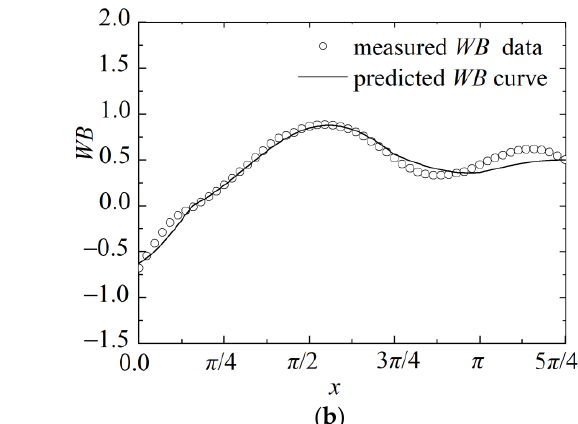
Figure 10. Comparisons of measured curve and predicted curve: ( a ) comparison of predicted 𝑞 √ℎ⁄ − 𝑛 √ℎ⁄ curve and measured data; ( b ) comparison of predicted 𝑚 ℎ⁄ − 𝑛 √ℎ⁄ curve and measured data.